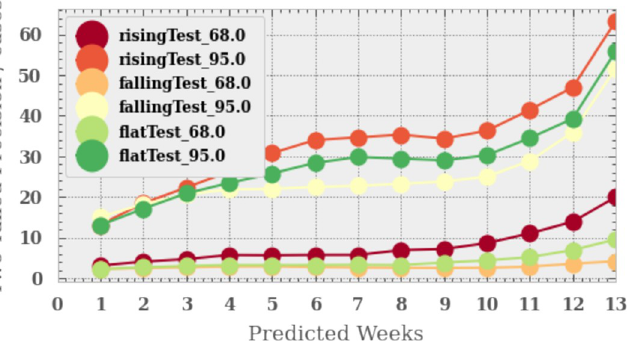
Fig 5. The two-tailed precision for the algorithm as a function of predicted week for the three scenarios and two confidence intervals (68% and 95%).